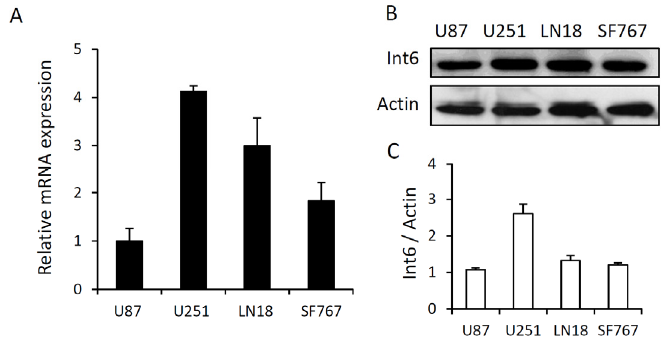
Figure 1. Basal Int6/eIF3e expression in four different glioblastoma cell lines. ( A ) Graph representing Int6 mRNA levels in LN18, SF767, U87 and U251 glioma cells analyzed by qRT-PCR ( n = 4); ( B ) Western blot analysis showing basal Int6 protein expression in LN18, SF767, U87 and U251 glioma cells ( n = 5); ( C ) Western blot quantifications showing the ratio Int6/eIF3e/Actin of at least 5 independent